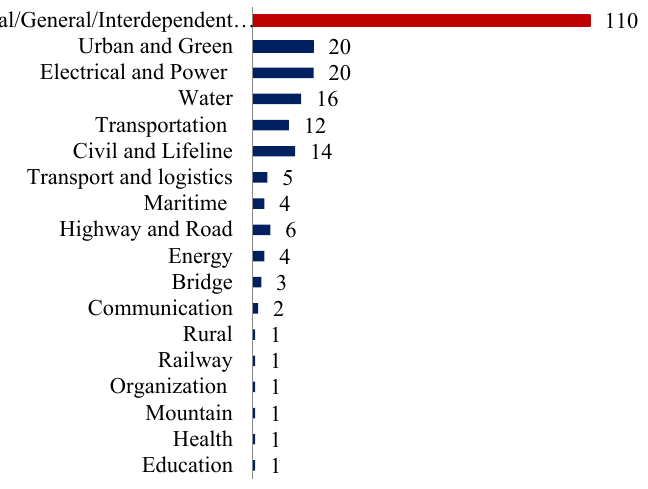
Figure 3. Number of publications by infrastructure type (222 in total).